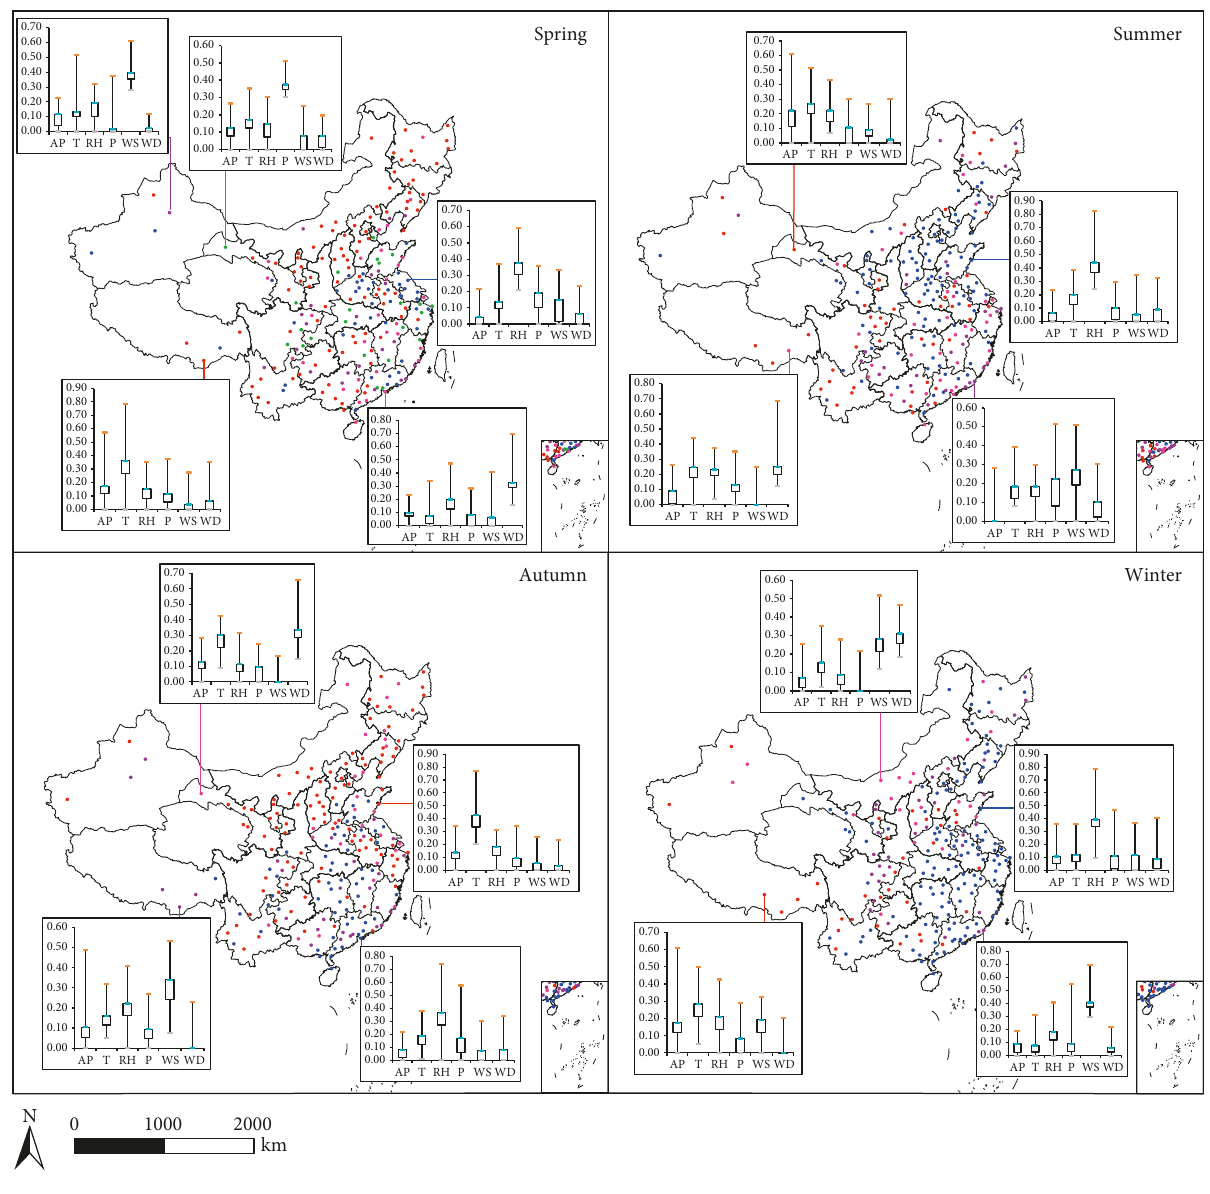
Figure 12: Relationship between SO 2 concentration and meteorological